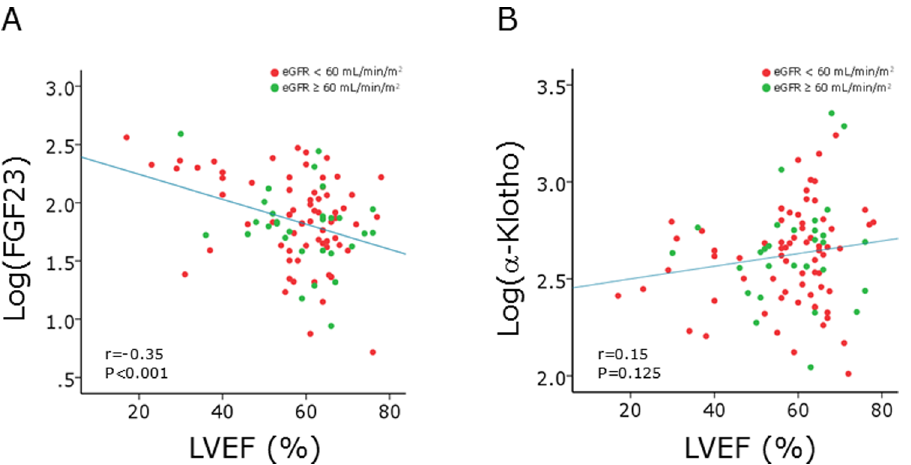
Figure 1. Correlation between FGF23, a -Klotho and left ventricular ejection fraction (LVEF). A. Correlation between log(FGF23) and LVEF. B. Correlation between log( a -Klotho) and LVEF. Pearson’s correlation analysis was performed. Green and red closed circles indicate patients with eGFR of $ 60 mL/min/1.73 m 2 and those with eGFR of , 60 mL/min/1.73 m 2 , respectively.